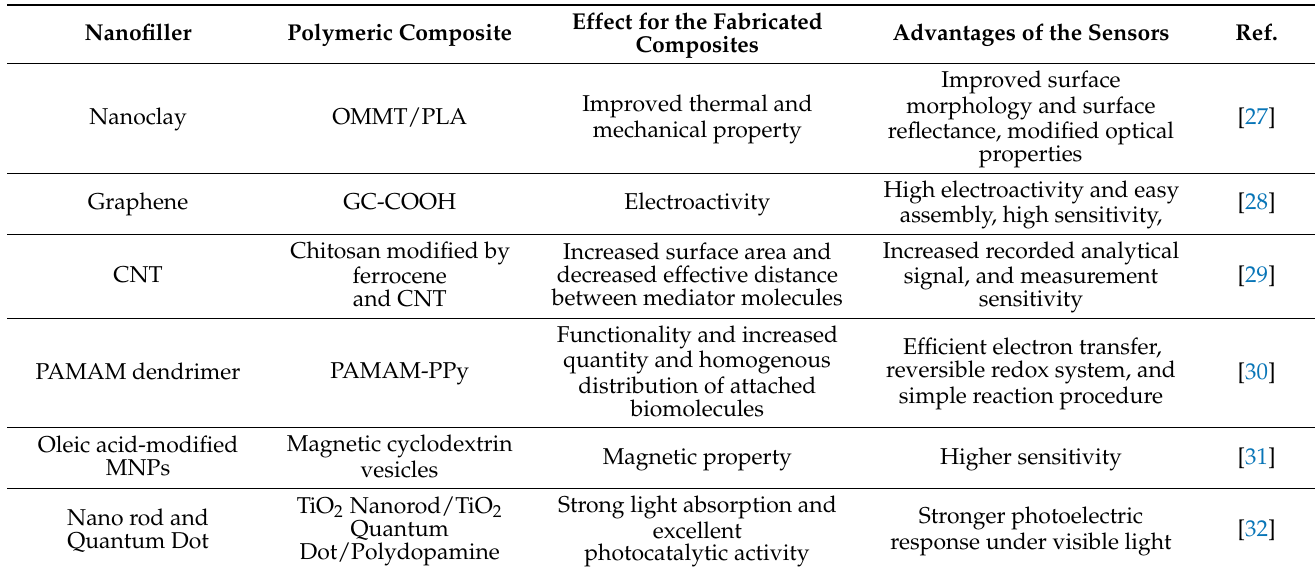
Figure 1. Effect of nanofiller materials on polymer nanocomposite properties. Reprinted with permission from ref. [20]. ©2018, Elsevier. Table 1. The effect of several nanofillers on the improved properties of polymeric nanocomposites and their sensors.